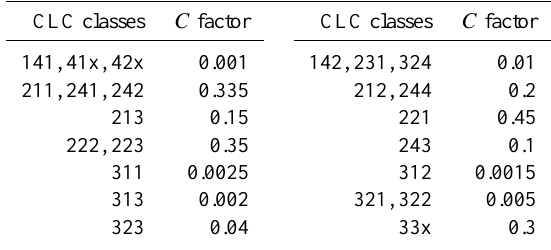
Table 2. The cover management factor is computed by processing the third level of the 15th version of the Corine Land Cover 2006 (CLC) database (European Environment Agency, 2011). A unique C factor value is associated (aiming at describing the European av- erage conditions) with each of the 44 CLC classes. The table is from Bosco and de Rigo (2013), where further information on the com- puted cover management factor is